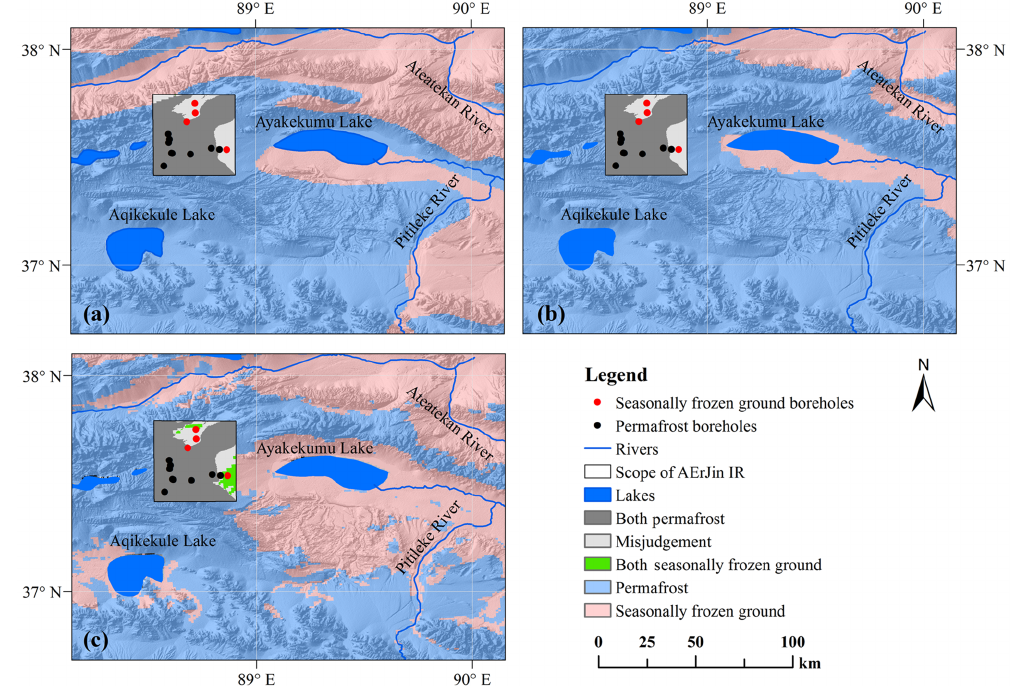
Figure 5. Comparison of the three maps in and around the AErJin investigated region ( a TP-1996, b TP-2006, c TP-2016).